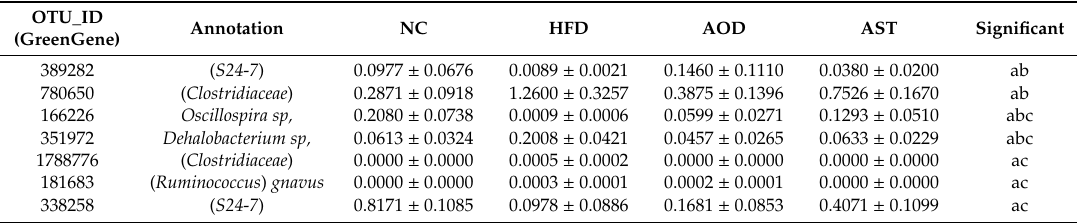
Table 1. Operational taxonomic units (OTUs) significantly impacted by AOD and AST in the gut microbiome in